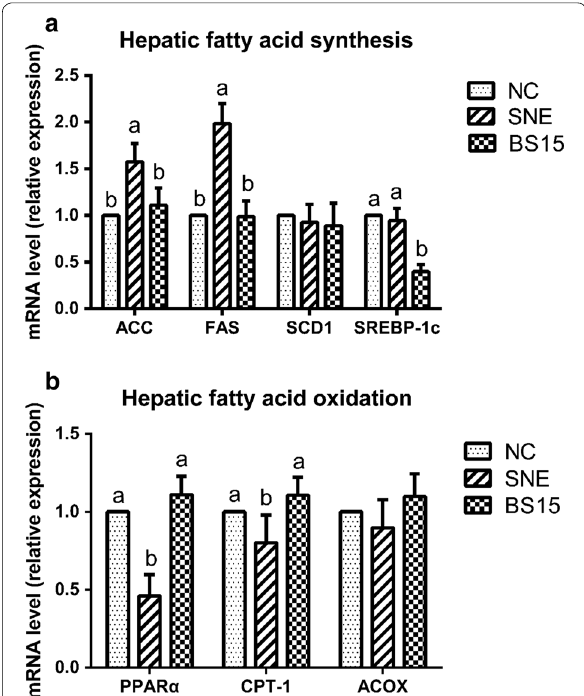
Fig. 3 The relative mRNA expressions of lipid metabolism related enzymes in liver. Means in the same row with no superscripts or with a common superscript letter do not differ significantly (P < 0.05). Data are presented with the mean standard deviation (for six replicates ± of one chick per cage). a , b The relative expression of ACC , FAS , SCD 1, SREBP -1c, PPAR α, CPT -1 and ACOX , respectively